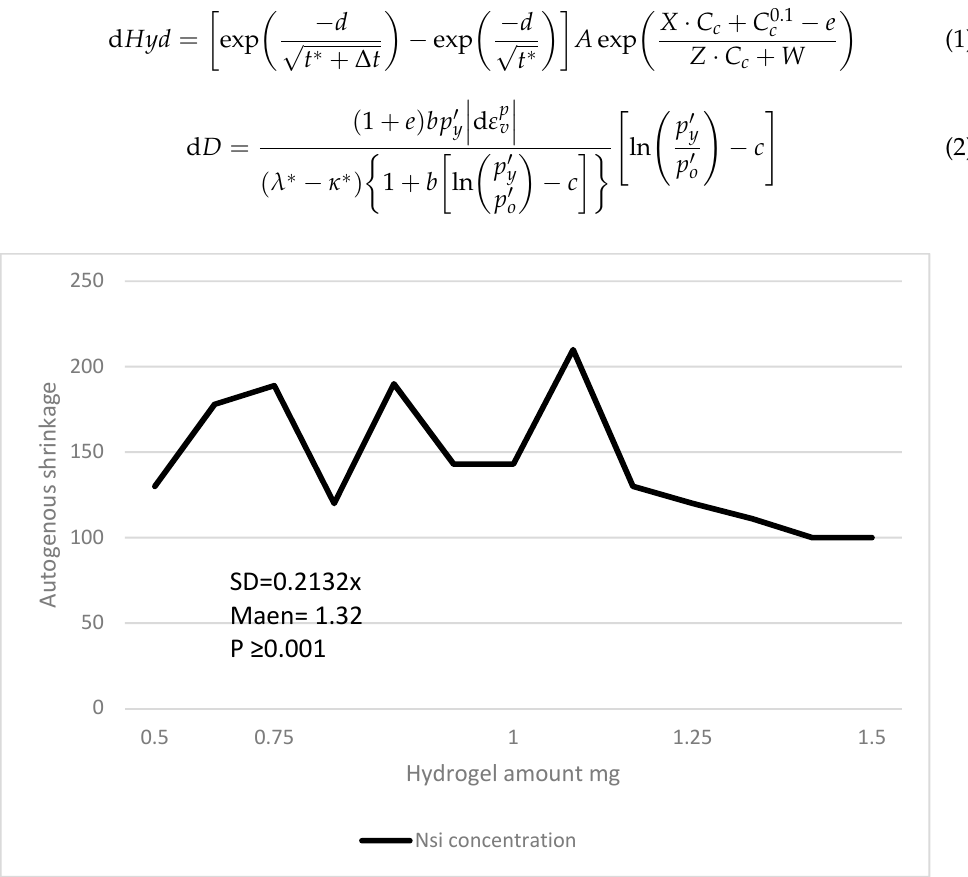
Figure 8. Decrement in autogenous shrinkage of cement-soil pastes while adding hydrogel.